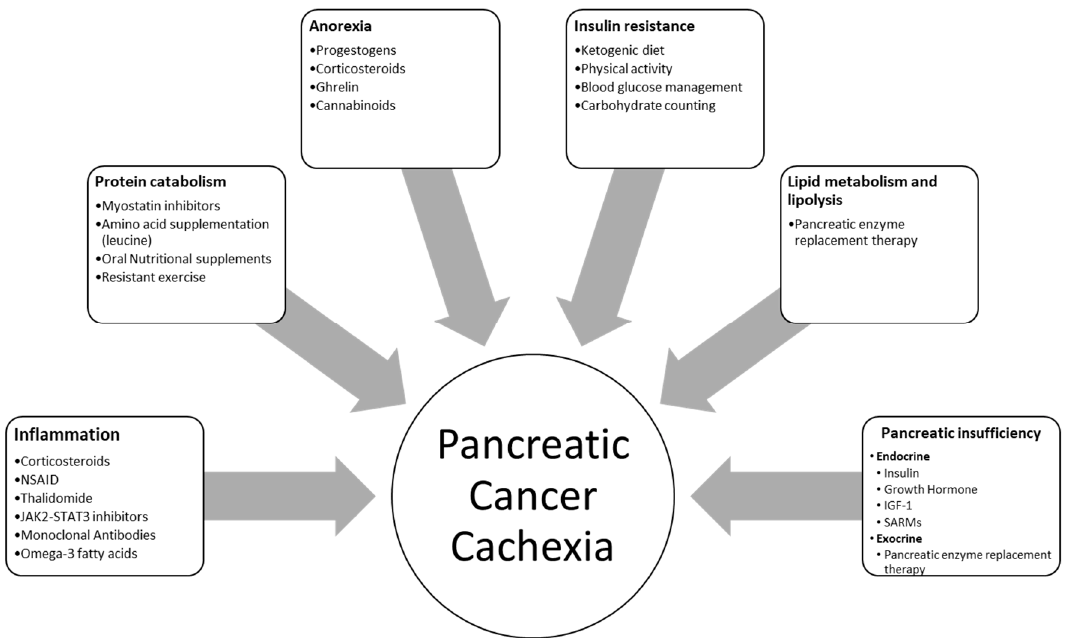
Figure 2. Conditions which are linked with pancreatic cancer cachexia and their therapeutic management. NSAID: nonsteroidal anti-inflammatory drugs; JAK: Janus kinase; STAT: signal transducer and activator of transcription; IGF: insulin-like growth factor; SARMs: selective androgen receptor modulators.